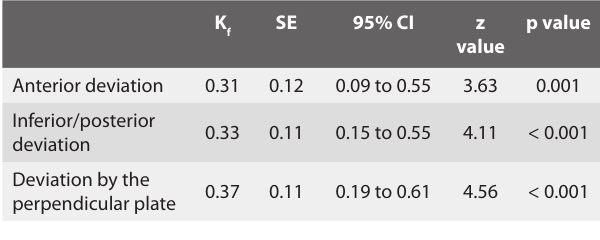
Table 1. Agreement analysis for endoscopic evaluation of nasal septal deviation.